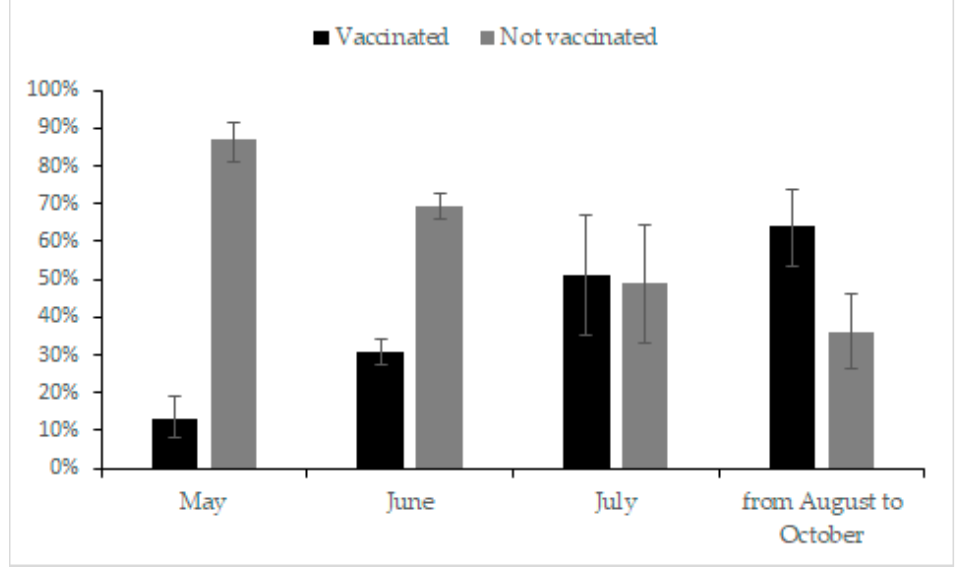
Figure 2. Vaccination rate of Chinese patients with rheumatic diseases in different time periods. Table 4. Adverse events after vaccination of patients with RDs a